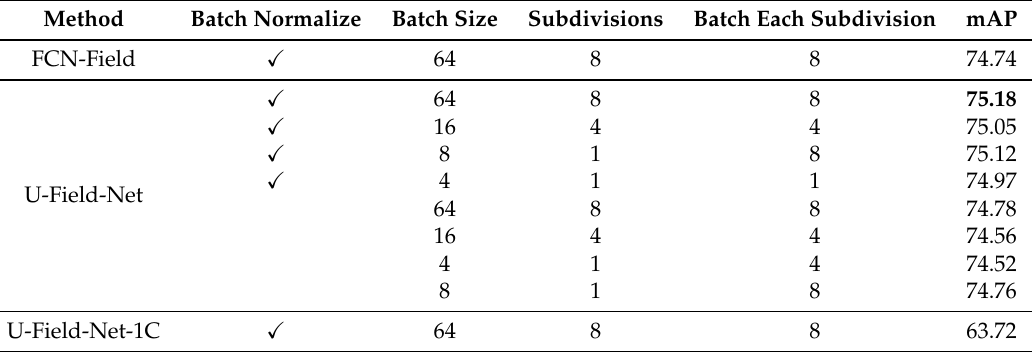
Table 1. Results of ablation studies on the DOTA dataset at the training. We built 8 models by adding batch normalize to the convolutional layers and using different amounts of batch size in the